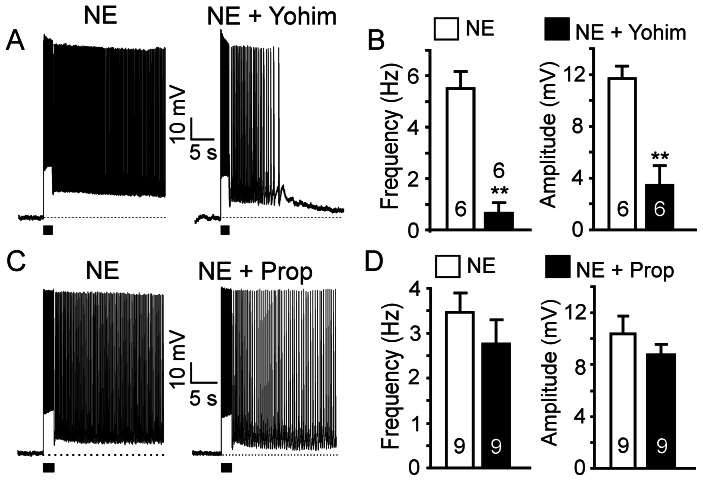
α2 adrenoceptors contribute to NE-induced persistent firing.(A) NE-induced persistent firing was partially suppressed by the selective α2 adrenoceptor antagonist yohimbine (Yohim, 10 µM; n = 6). (C) NE-induced persistent firing was not affected by the βadrenoceptor antagonist propranolol (Prop, 10 µM; n = 9). (B) and (D) Quantitative effects of yohimbine and propranolol on firing frequency and amplitude of plateau potentials. Values are mean ± SEM. ** p<0.01.